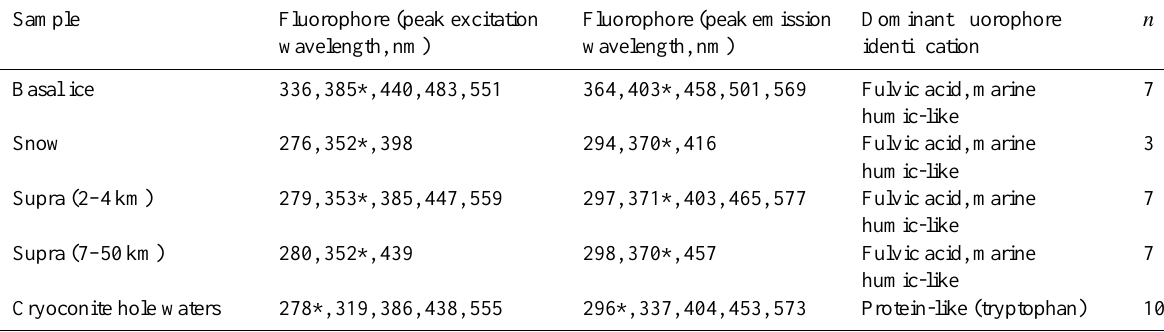
Table 2. Summary of the dominant fluorophores (denoted by *) in different glacial environments ( λ em = λ ex + 18nm).